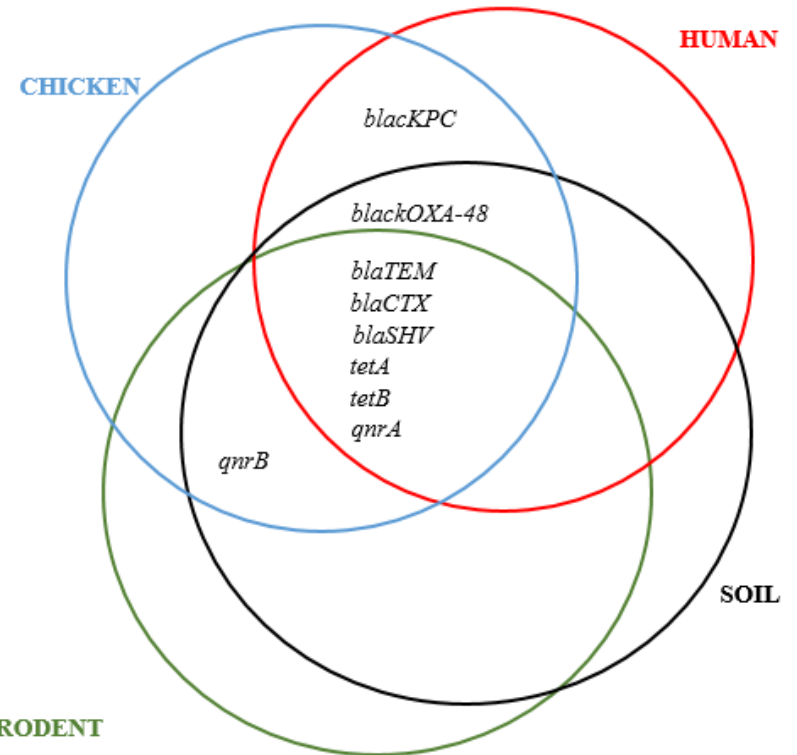
Figure 4. Distribution of resistance genes in various sample sources.